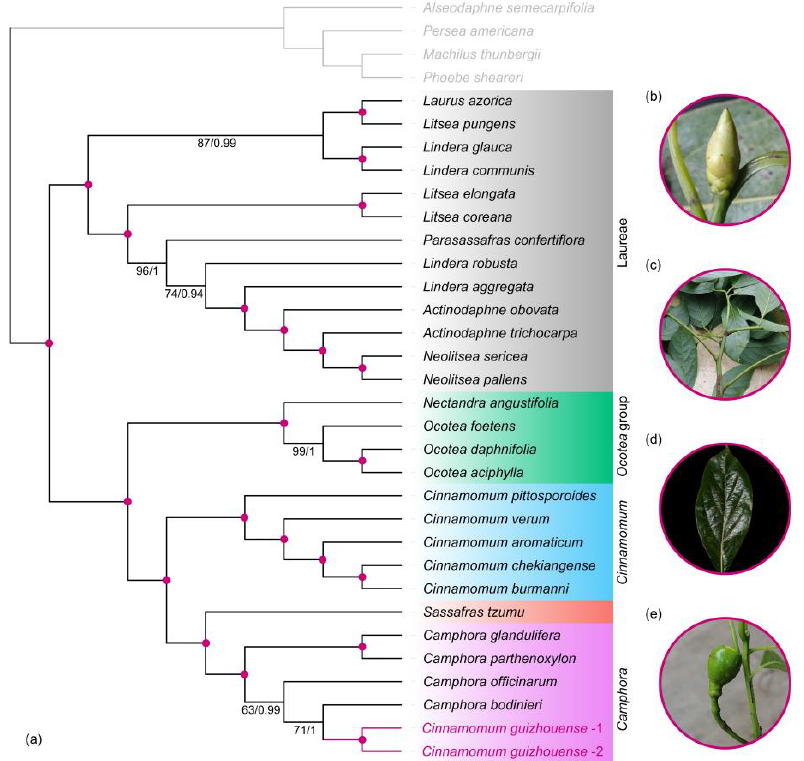
Figure 3. Phylogenetic tree displaying the phylogenetic position of Cinnamomum guizhouense C.Y. Deng et al. ( a ) Phylogenetic tree inferred from Bayesian inference and maximum likelihood analysis based on complete plastomes. Ultrafast bootstrap support values (< 100%) and Bayesian posterior probabilities (<1) are shown below the branches; ( b – e ) Morphology of Cinnamomum guizhouense ; ( b ) Large perulate terminal buds; ( c ) Alternate leaves; ( d ) Pinnately-veined leaf; ( e ) Deep fruit